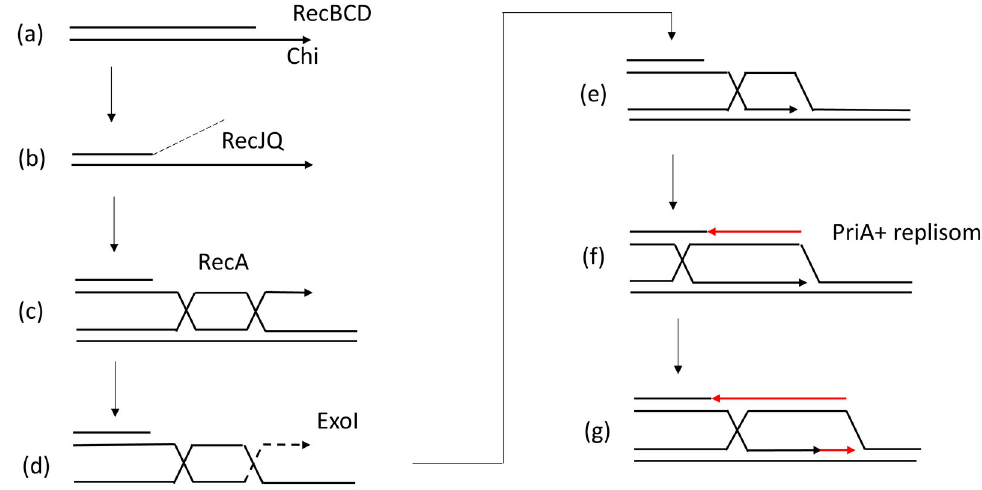
Fig 9. Model of formation of E . coli DSB repair intermediates. At a DSB, RecBCD resects the DNA end up to a Chi site, whereupon it continues to degrade the 5’ ended strand to produce a molecule with a 3’ single-stranded overhang (a).